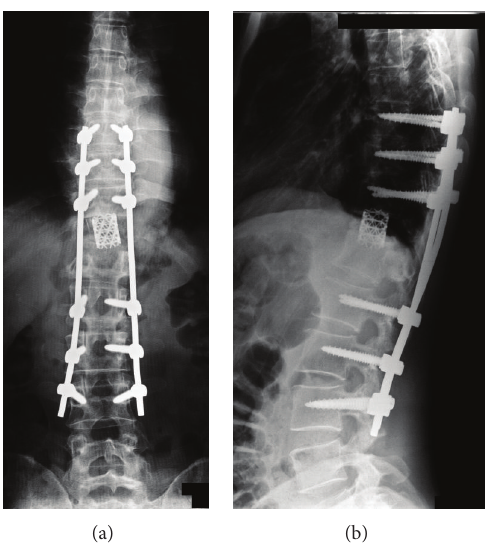
Figure 5: Images after the second surgery, HE staining ( × 40). (a) Frontal view on plain X-ray radiography. (b) Leteral view on plain X-ray